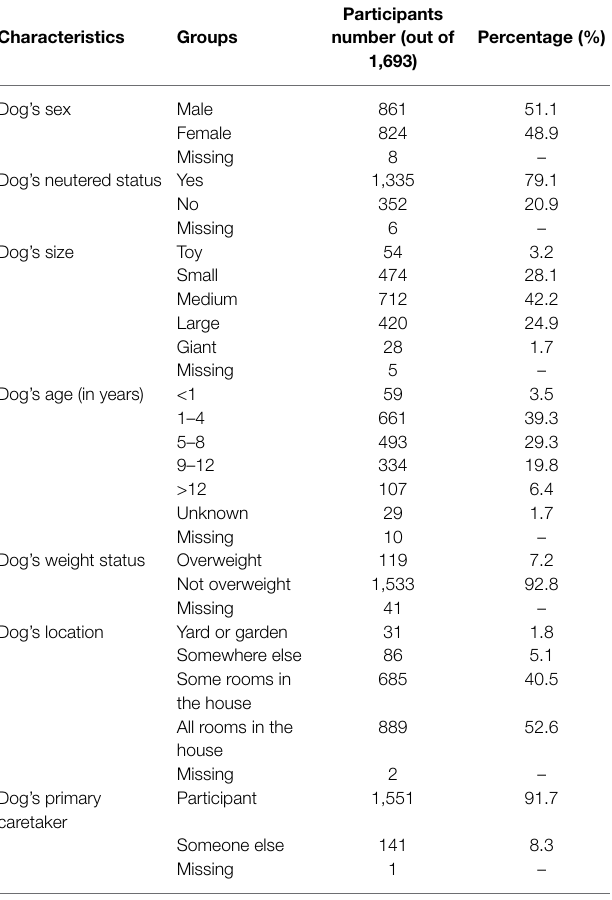
TABLE 1 | The demographic characteristics of the dogs whose owners filled out the questionnaire.